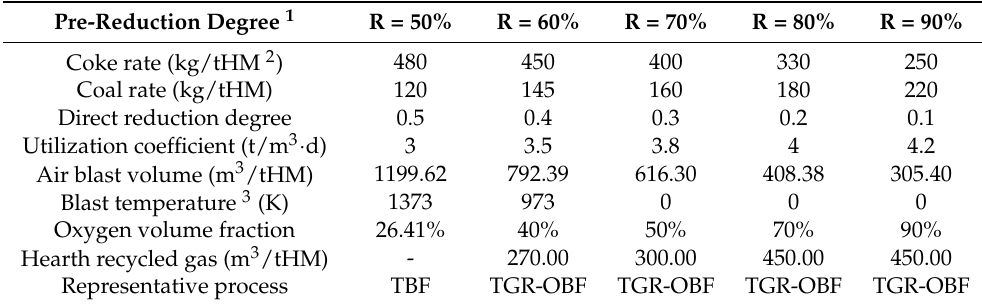
Table 1. Correspondence between different